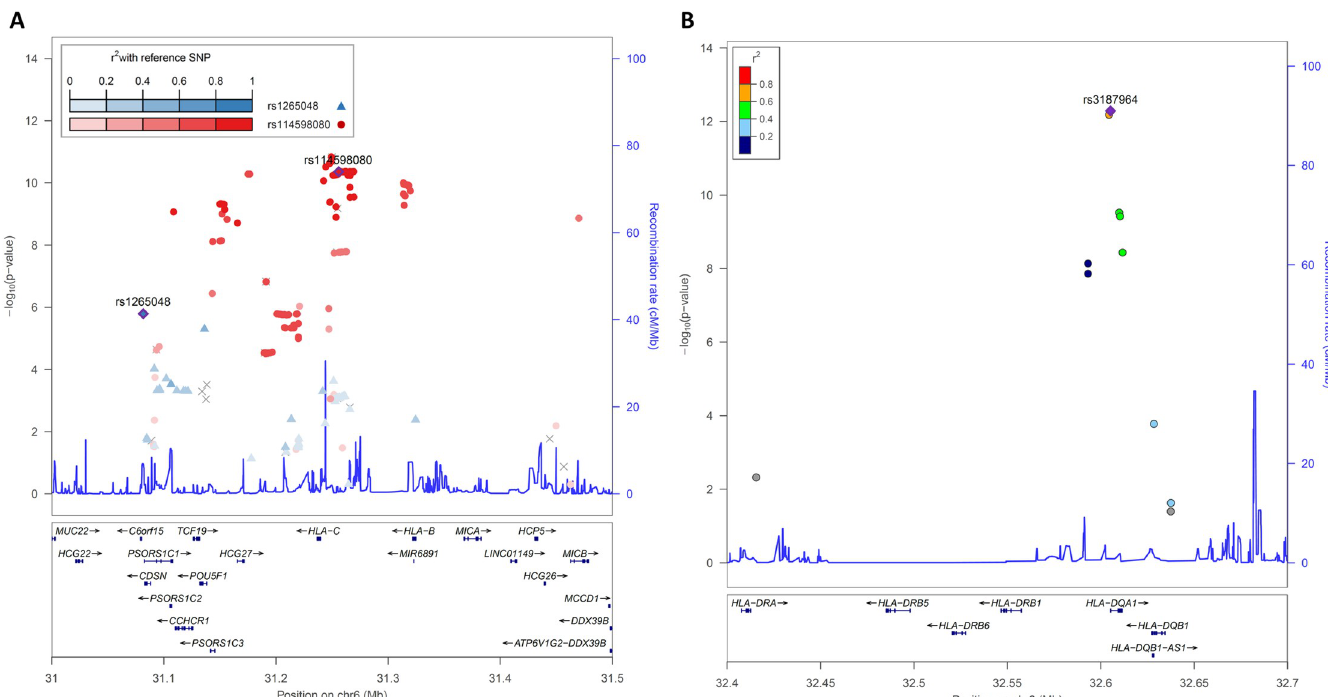
Fig 2. Regional association plot for HLA class I (A) and class II (B) SNPs in the case/control replication sample. Locus zoom plot showing one-tailed p -values for association within the HLA region. The three independent SNPs identified by multivariate analysis, rs1265048 (A), rs114598080 (A) and rs3187964 (B), are represented as blue, red and purple diamonds, respectively. The colors indicate the pairwise linkage disequilibrium ( r 2 ) with the three independent SNPs, as calculated in the 1000 Genomes KHV population. SNPs not found in the reference populations are shown in gray.